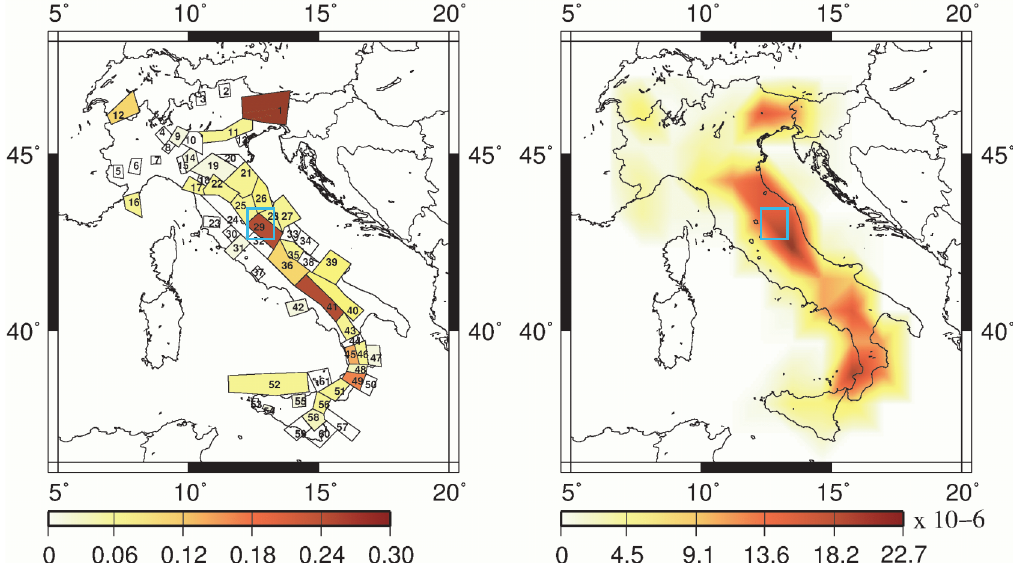
Fig. 4. Cinti et al. (2004; left panel) and Faenza et al. (2003; right panel) forecasts for M 5.5+ events for the next 10 years. The left panel (A) reports the probability to have at least one event in next 10 years for each seismotec- tonic zonation. The right panel (B) reports the same quantity per unit of surface (in Km 2 ). The blue box represents the Colfiorito area. For more details see also